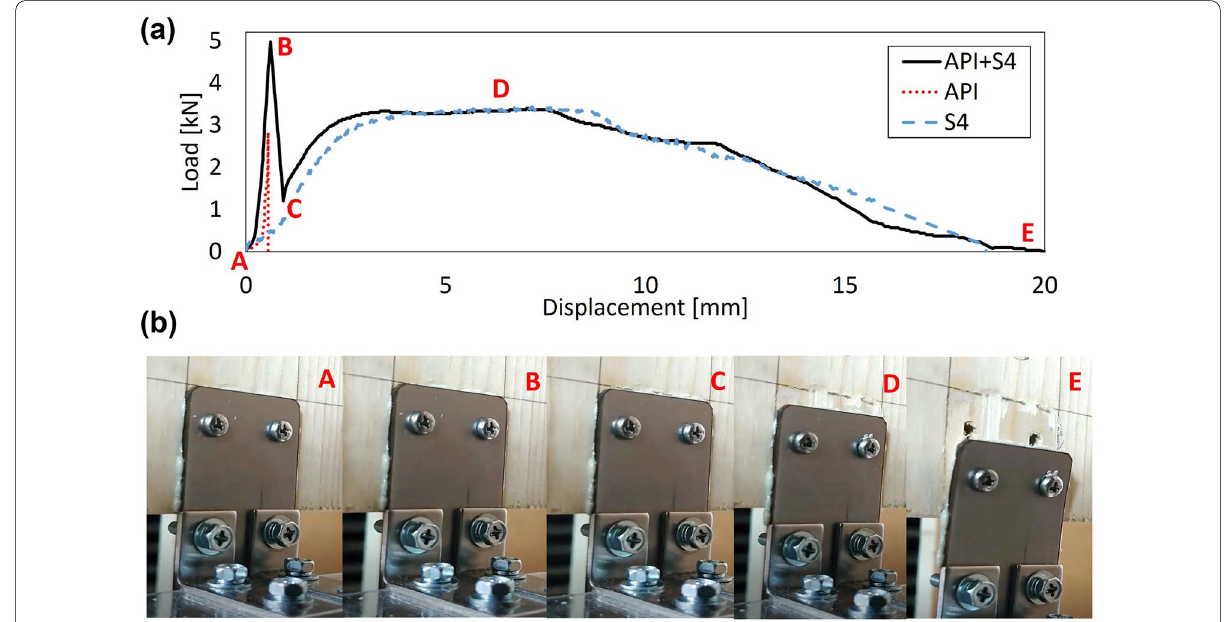
Fig. 4 a Load–displacement curves for the specimens with API; screw-only (“S4”), API adhesive-only (“API”), and hybrid (“API Snapshots of deformation and failure processes for the hybrid joint. The letters “A” to “E” correspond to those in